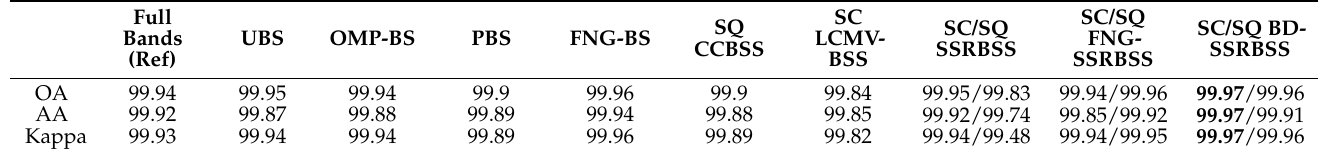
Table 11. HybridSN classification results of using the bands described in Table 5 for Salinas